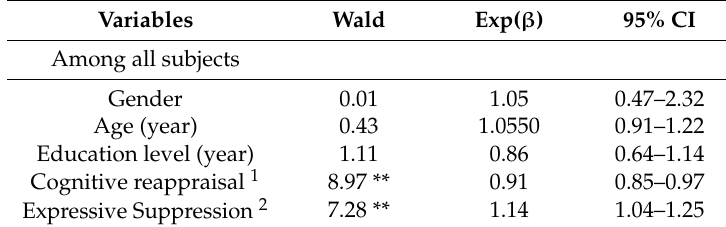
Table 2. Logistic regression to evaluate the predictive value of emotional regulation in IGD with control of gender, age, and educational